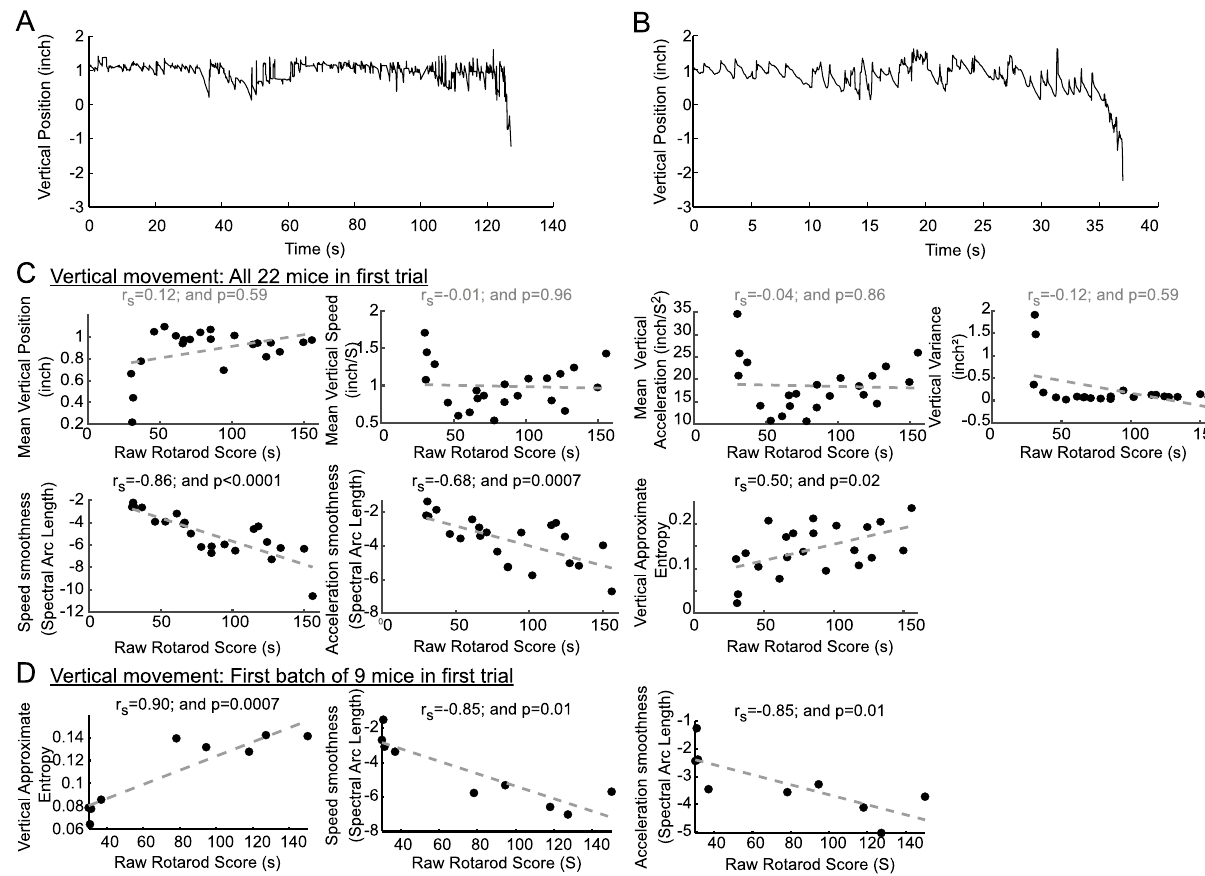
Figure 2. Relationship of first trial vertical paw position intra-session features with rotarod scores across mice. ( A , B ) Representative vertical paw position changes over time for mice with greater ( A ) and smaller ( B ) rotarod scores. A regular “saw-tooth” pattern (indicating a lower approximate entropy) characterizes mice with lower rotarod scores in B compared to mice in A. ( C , D ) Scatter plots for intra-session features with their best fit